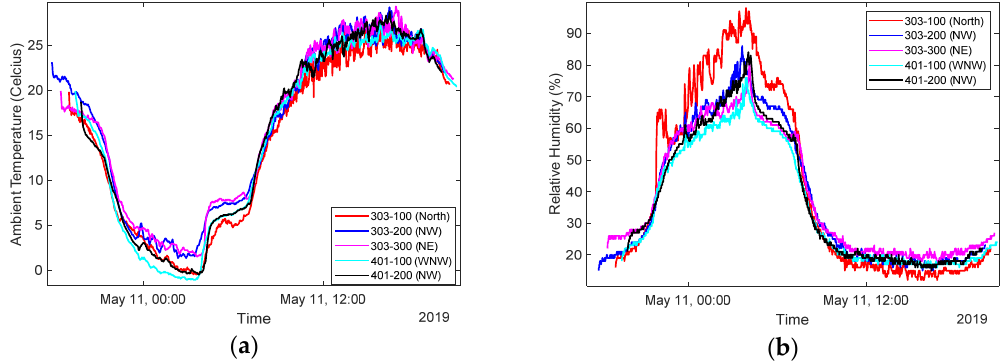
Figure 4. ( a ) Ambient temperature variation at different sensor locations for a period of 24 h near the prescribed fire area; ( b ) relative humidity variations.